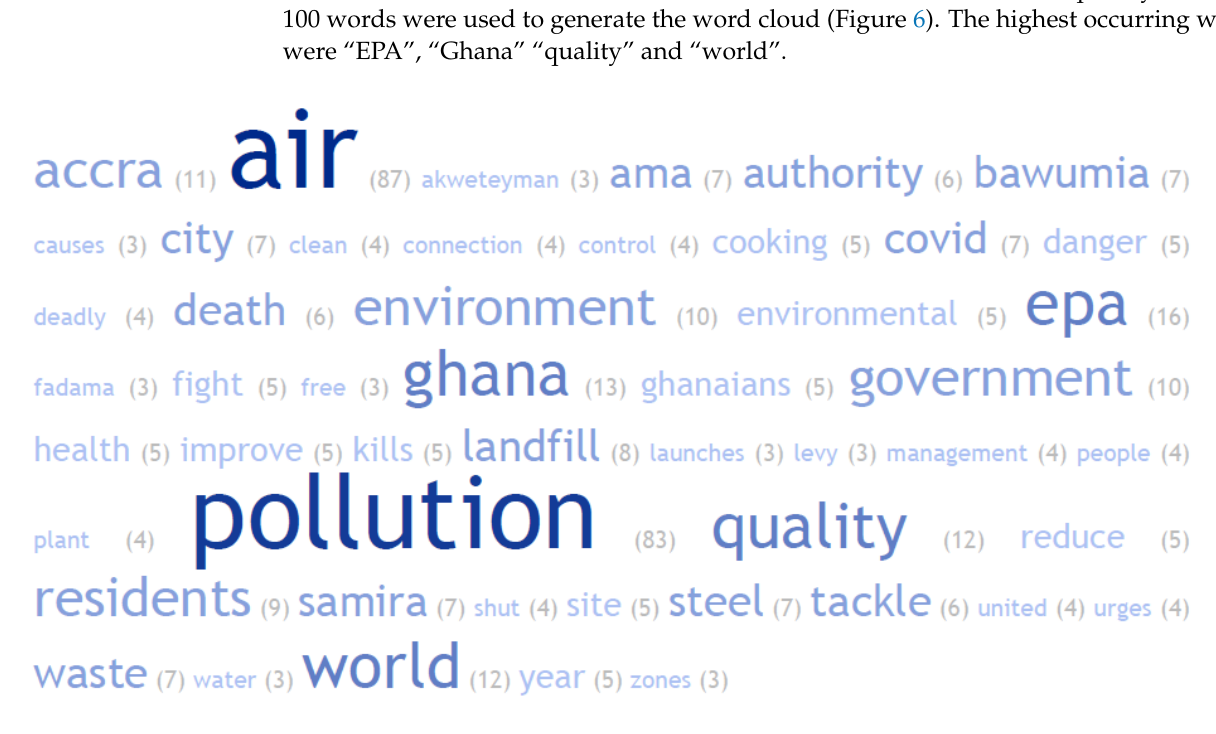
Figure 6. Word cloud of Air Pollution publication headlines .